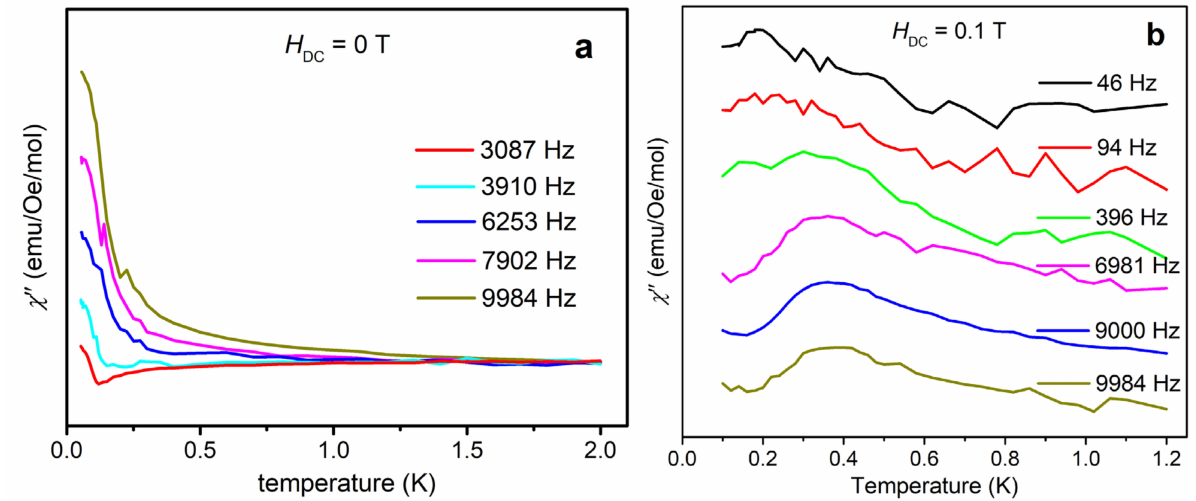
Figure 6. ( a ) Out-of-phase AC susceptibility χ ” measured under zero external magnetic field with various frequencies from 50 mK to 2 K. The peak tails below 0.5 K may indicate fast quantum tunneling of magnetization (QTM) via degenerate energy levels. ( b ) Out-of-phase AC susceptibility χ ” measured under 0.1 T external magnetic field with various frequencies from 46 to 9984 Hz in the temperature range of 0.1–1.2 K. Because the applied field suppresses QTM, the χ ” peaks are visible and show frequency dependence, indicative of field-induced SMM